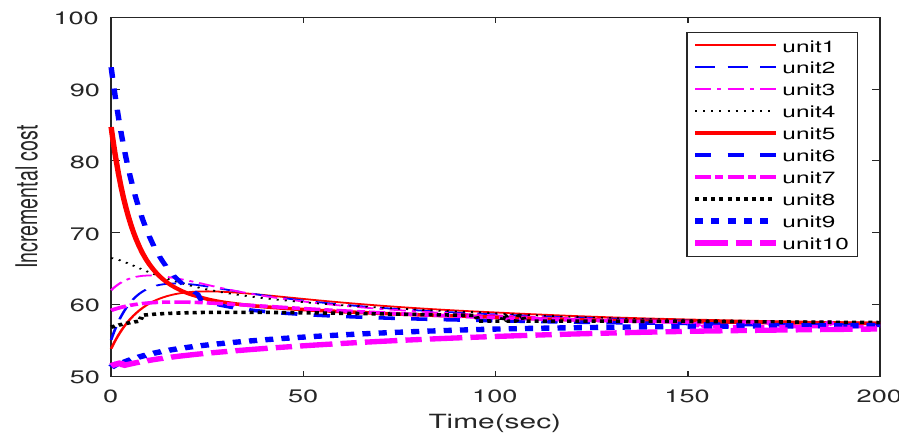
Figure 5. Consensus of ICs with the VPE. Table 3. Optimal output power of generation units and total cost in case of no capacity